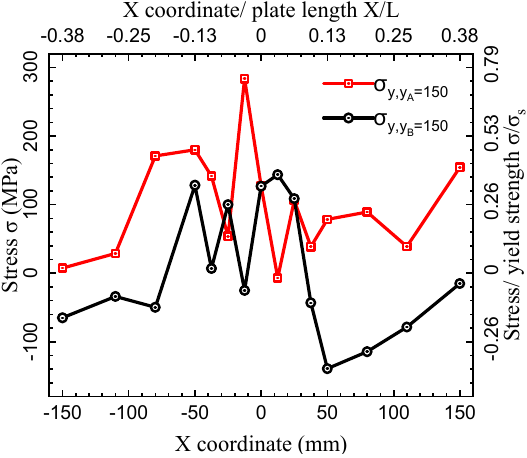
Figure 17. 𝜎 (cid:3052) on surfaces A and B. Figure 17. σ y on surfaces A and B.